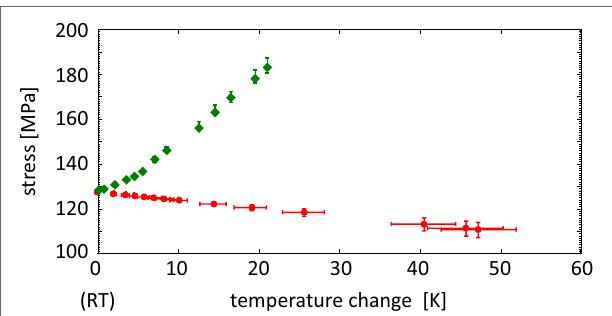
FIGURE 8 | Temperature increase near position 3 on the membrane measured with the thermal camera as a function of 1,550nm power indicating an approximately linear relationship and consequently a constant absorption. The smaller image in the right bottom corner of the graph shows a picture taken with the thermal